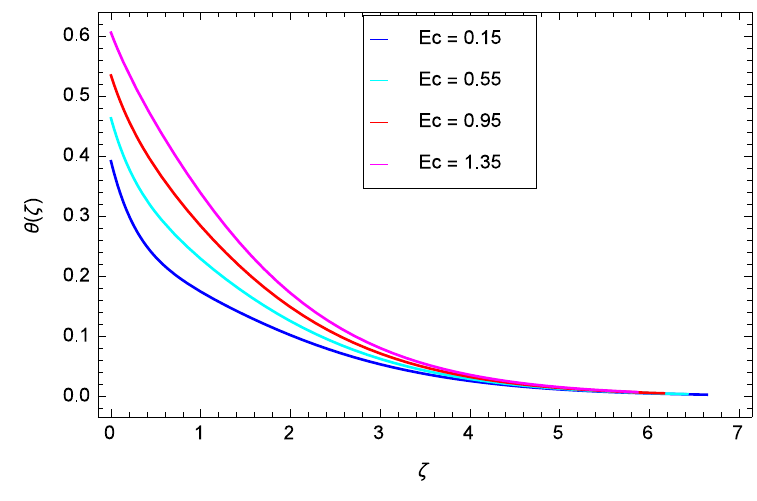
Figure 15. Influence of Ec on θ ( ζ ) .